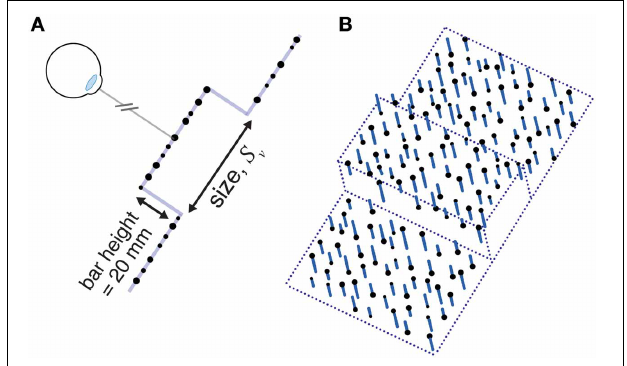
FIGURE 5 | A schematic diagram of the visual stimulus used in Experiment 2. (A) A profile view of a stimulus with 0% noise. (B) A cartoon of a stimulus with non-zero visual noise. Viewing distance was 500mm. See main text for specific details.